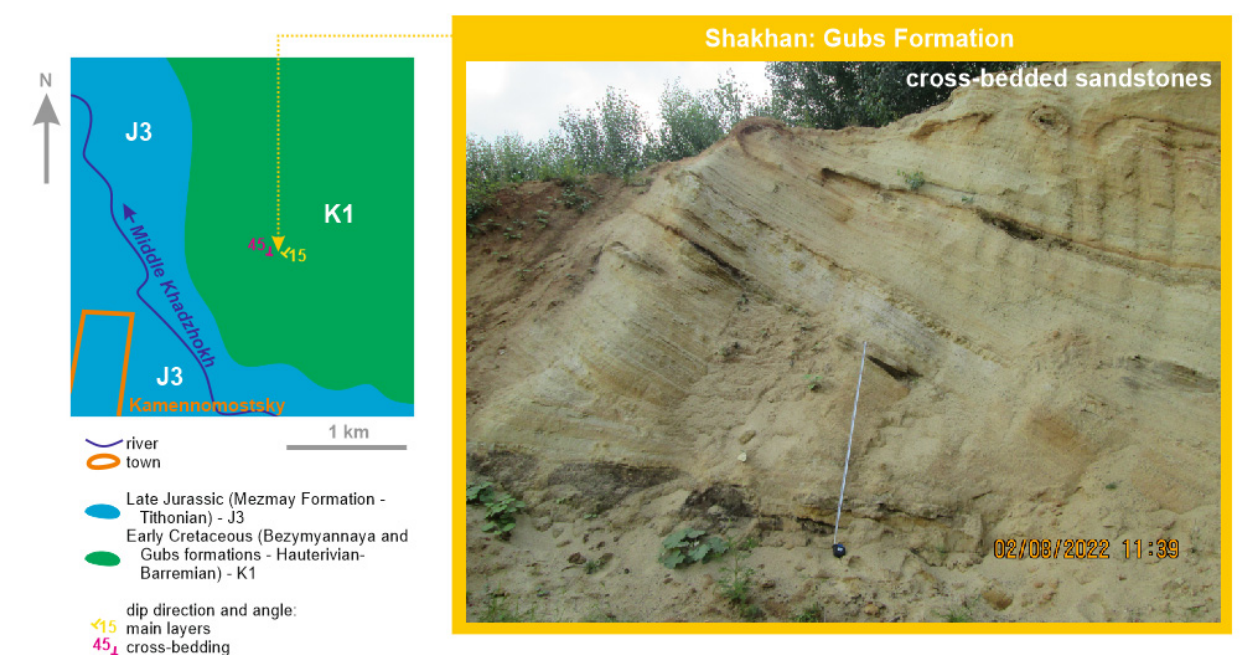
Figure 6. Shakhan locality: geological schemes and principal Cretaceous lithology with well-visible layering and cross-bedding (tape’s length is 2 m).